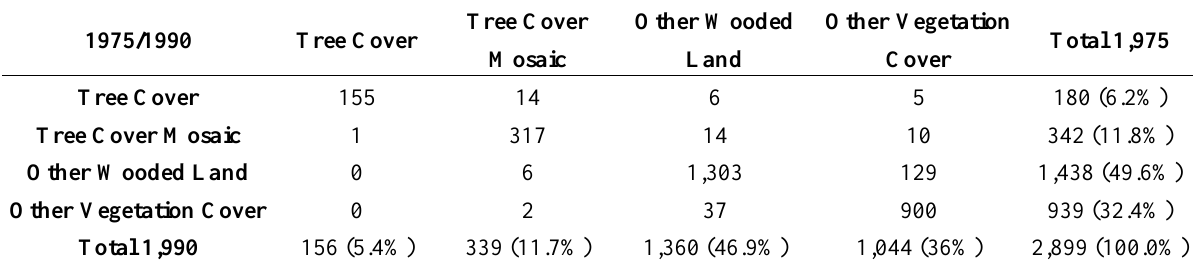
Table 1. Land cover transitions from 1975 to 1990 over West Africa (areas in thousands of km 2 , and in bracket, the proportion of each value compared to the total